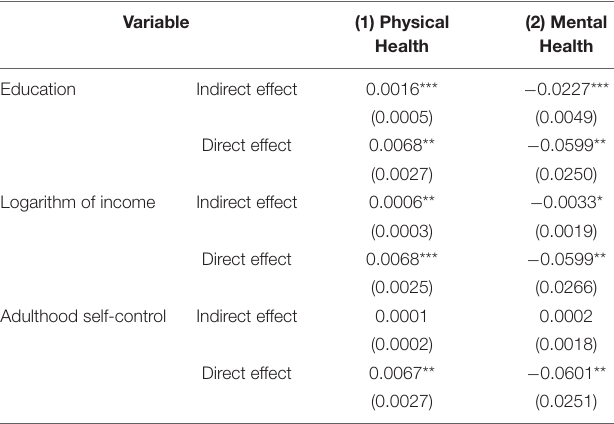
TABLE 6 | Mediating effects of education, income, and adulthood self-control in effects of adolescent self-control on physical and mental health in adulthood.